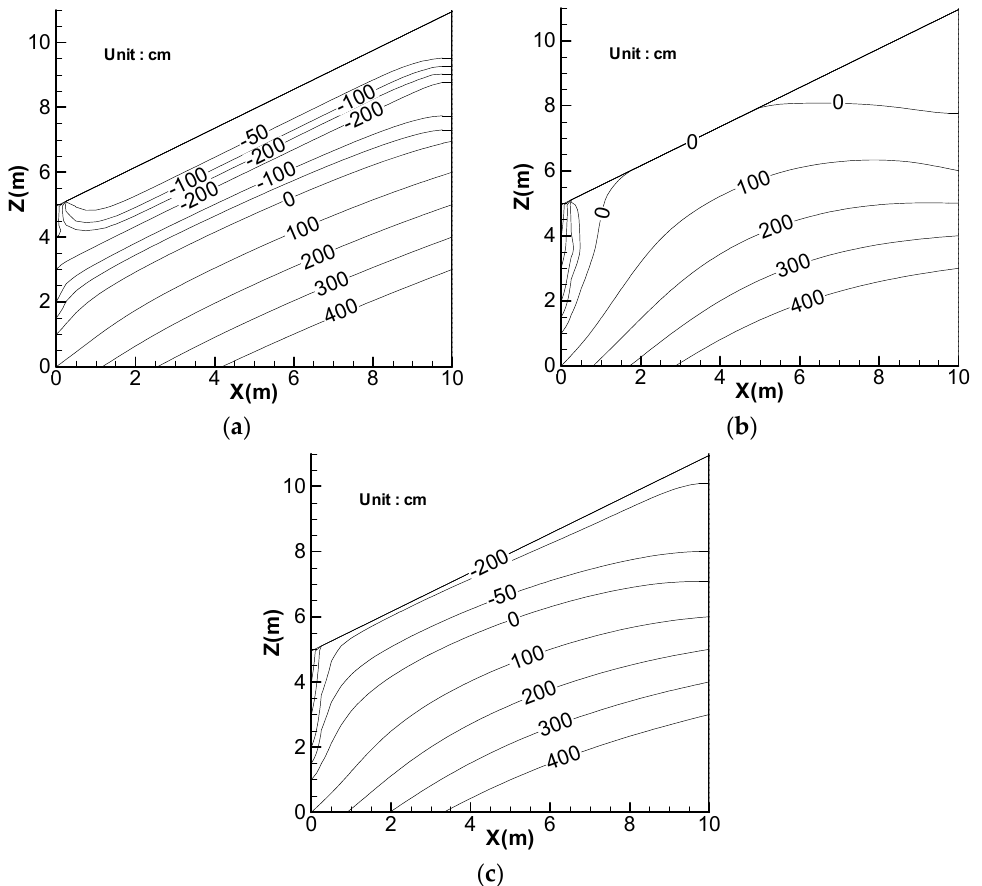
Figure 5. Pressure head contours for duration of 24 h with uniform rainfall of 400 mm at time: ( a ) 12 h; ( b ) 24 h; and ( c ) 36 h.